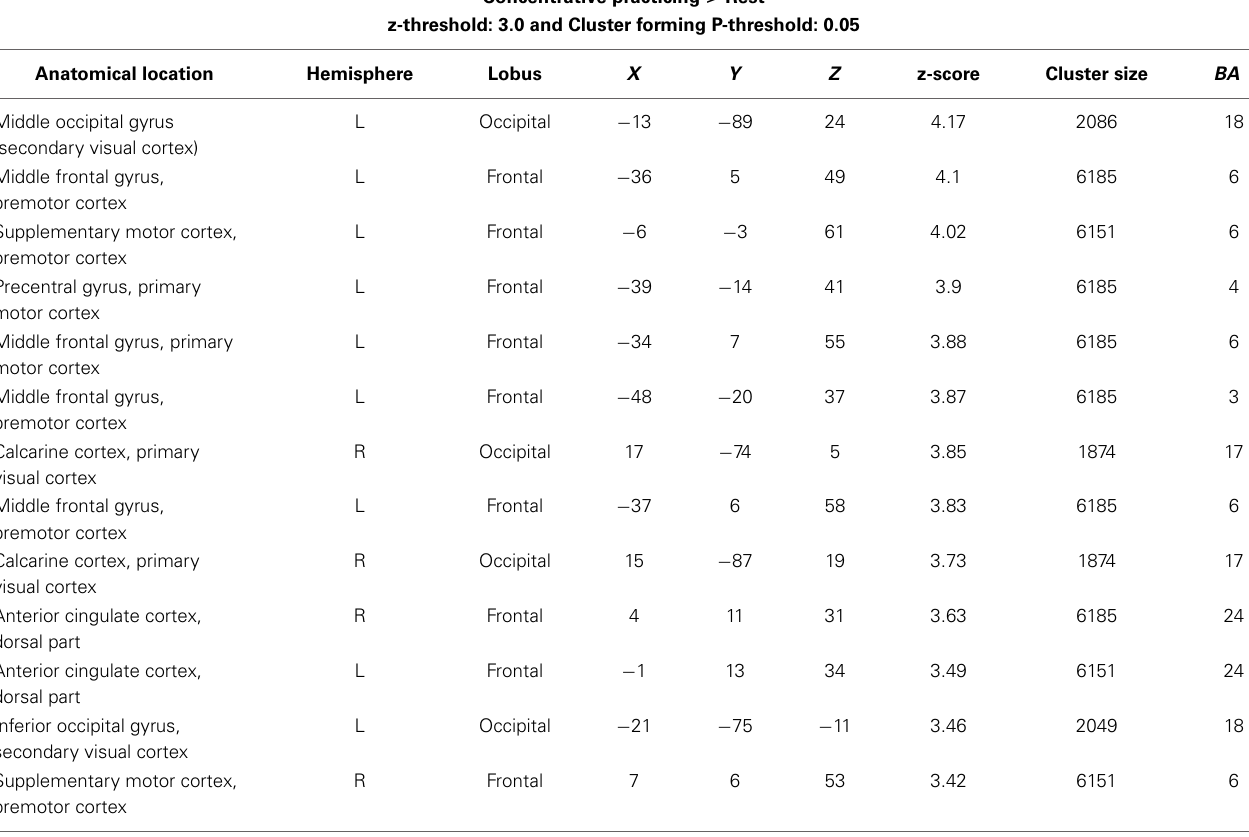
Table 3 | Cerebral regions with increased activity: concentrative practicing > rest.